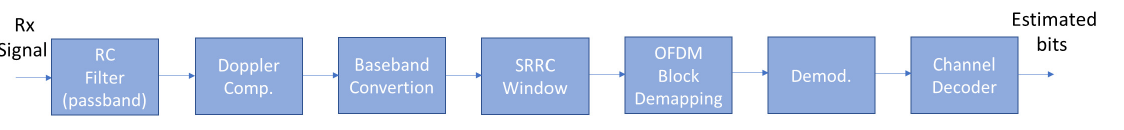
Figure 10. Modem: receiver operating at decoding